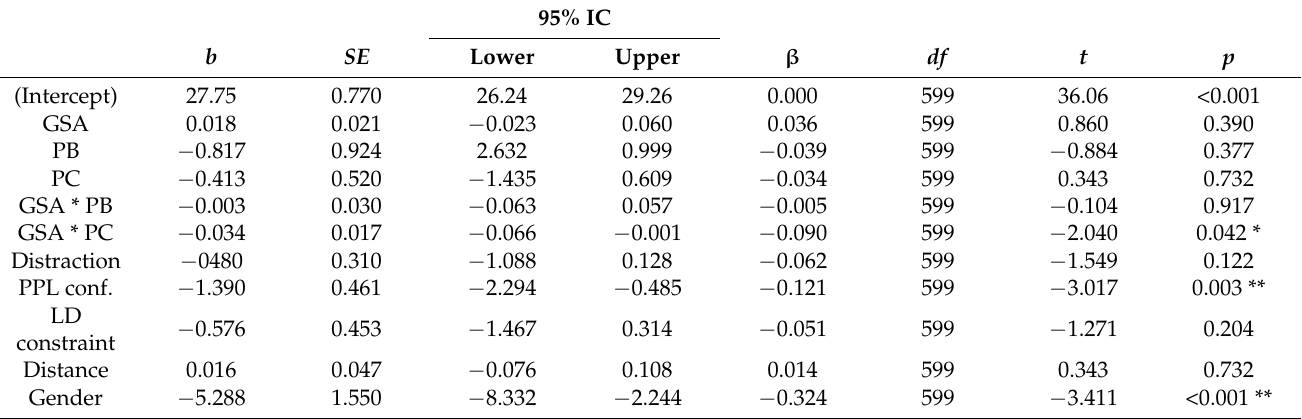
Table 3. Multiple linear regressions assessing associations between GS attendance, GS perception, the interaction between both, and prosocial behaviors (dependent variable), while controlling for distraction, number of people confined with, perceived lockdown constraint, distance, and gender.